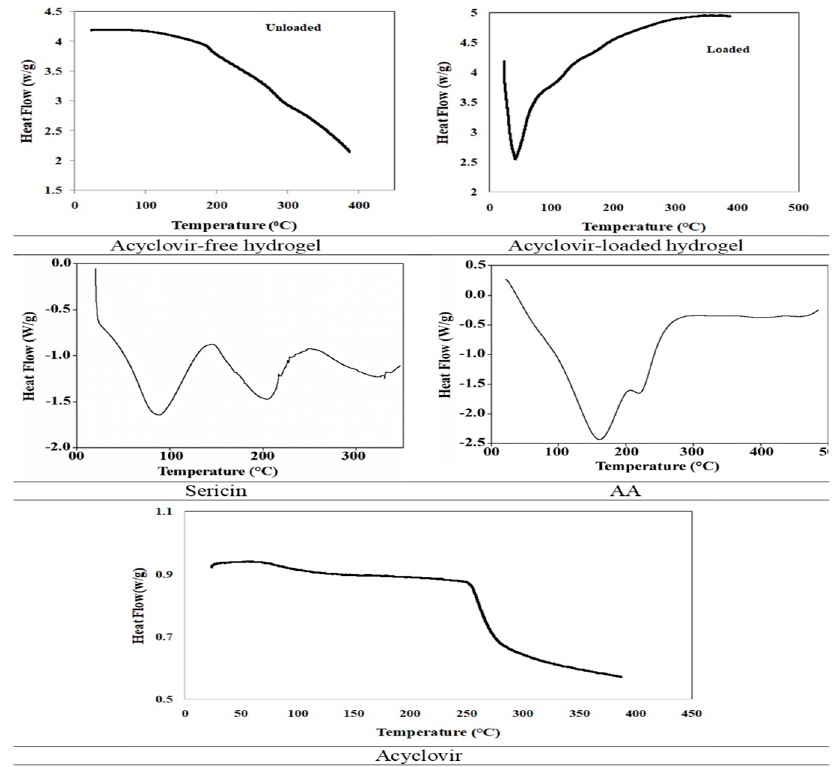
Figure 10 Differential Scanning Calorimetry (DSC) thermograms of various samples. Figure 10. Differential Scanning Calorimetry (DSC) thermograms of various